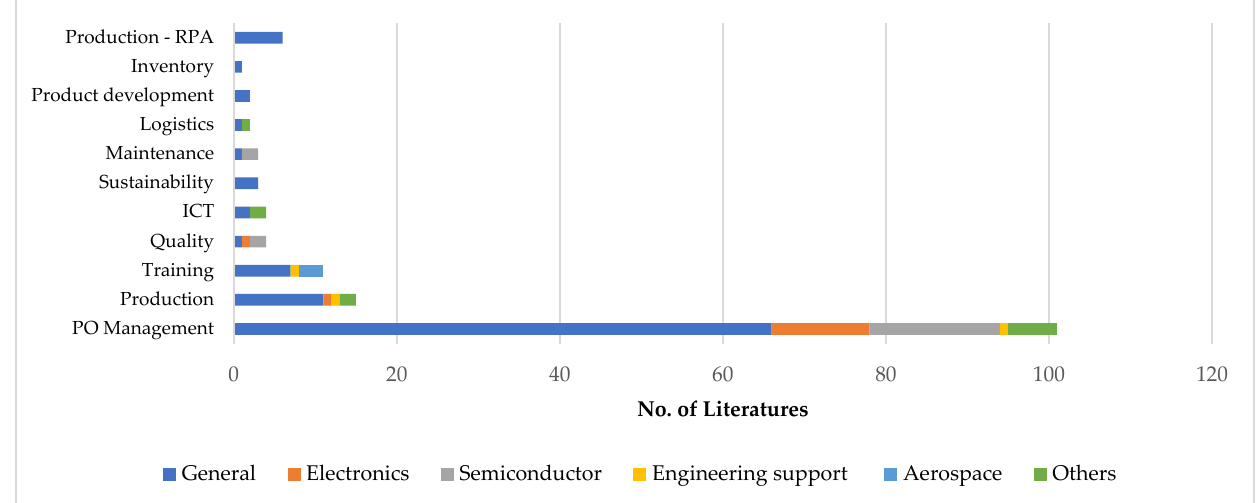
Figure 9. Research area according to the industries .